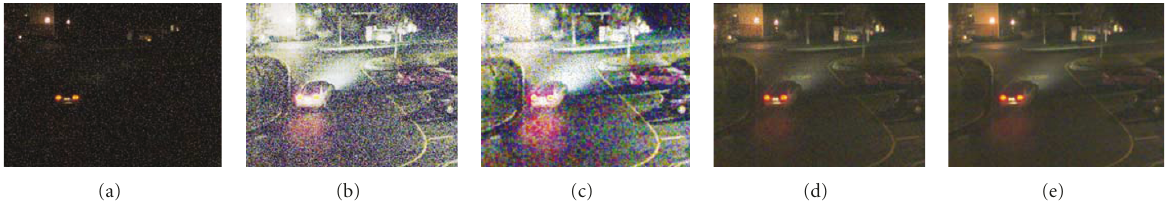
Figure 9: Underexposed video results. (a) Test video added by impulse ( p = 10%) noise. (b) Result of histogram equalization. (c) Result of ASTA filter followed by histogram equalization. (d) Result of ASTA system. (e) Result of our system.